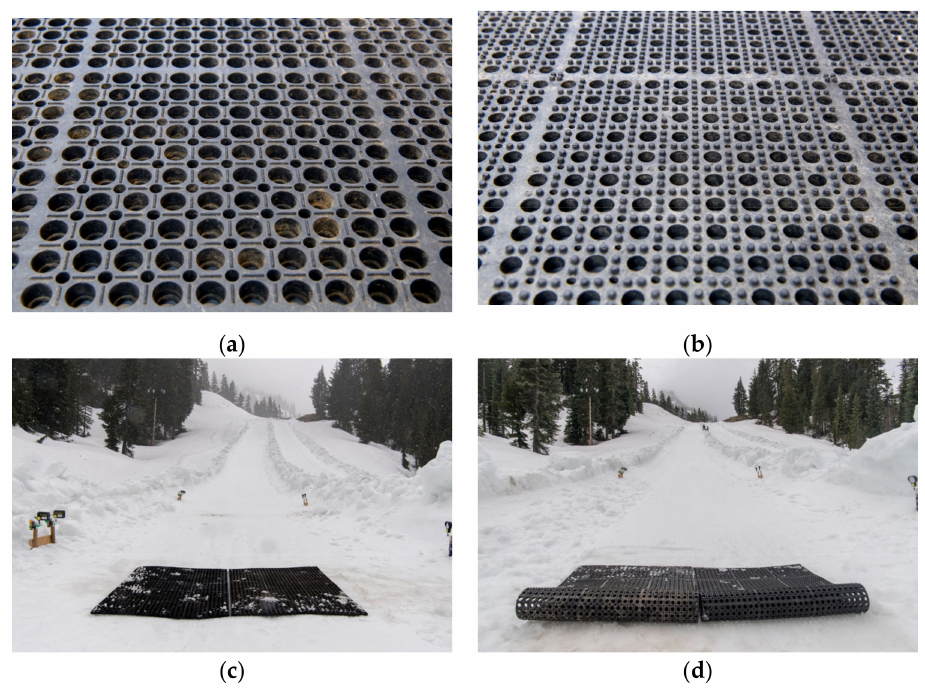
Figure 2. ( a ) Close-up view of a deceleration mat showing the “ribs” on the top surface ( b ) Close-up view of a deceleration mat showing the “projections.” (Bottom row) View uphill of the tubing lane, with the first set of deceleration mats in the following conditions: ( c ) flat , ribs and ( d ) folded , projections condition. Two mats (left to right) on the tubing run were used to increase the likelihood that the snow tube would ride fully over the